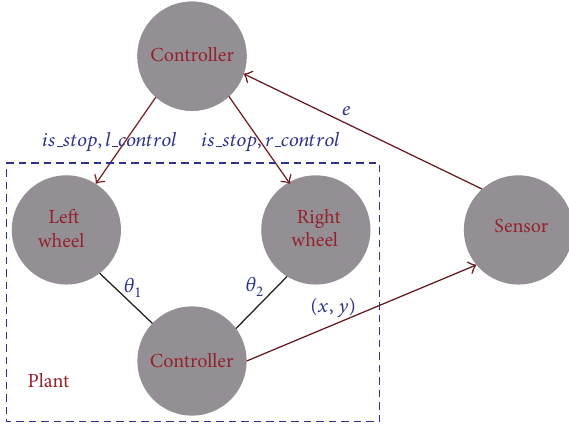
Figure 2: Network of hybrid automata for an